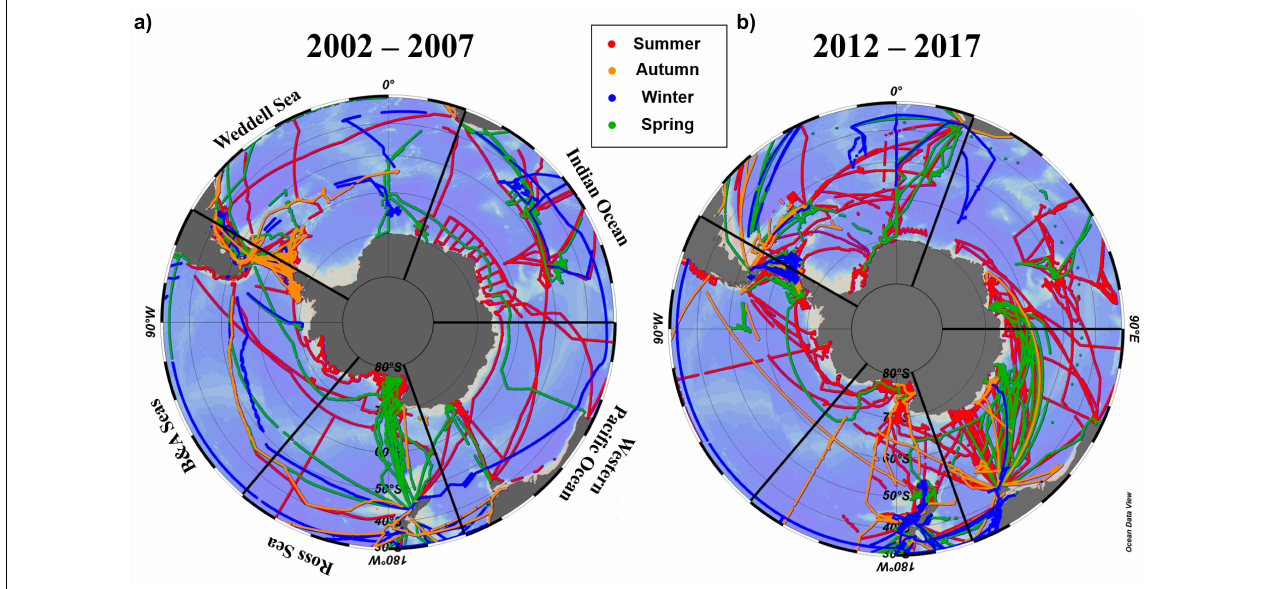
FIGURE 4 | Distribution of seasonal p CO 2 observational data used here from SOCAT version 2019 (Bakker et al., 2016) for (a) 2002–2007 and (b) 2012–2017. The seasonal periods computed were austral summer (JFM; red trajectories), autumn (AMJ; orange trajectories), winter (JAS; blue trajectories) and spring (OND; green trajectories).